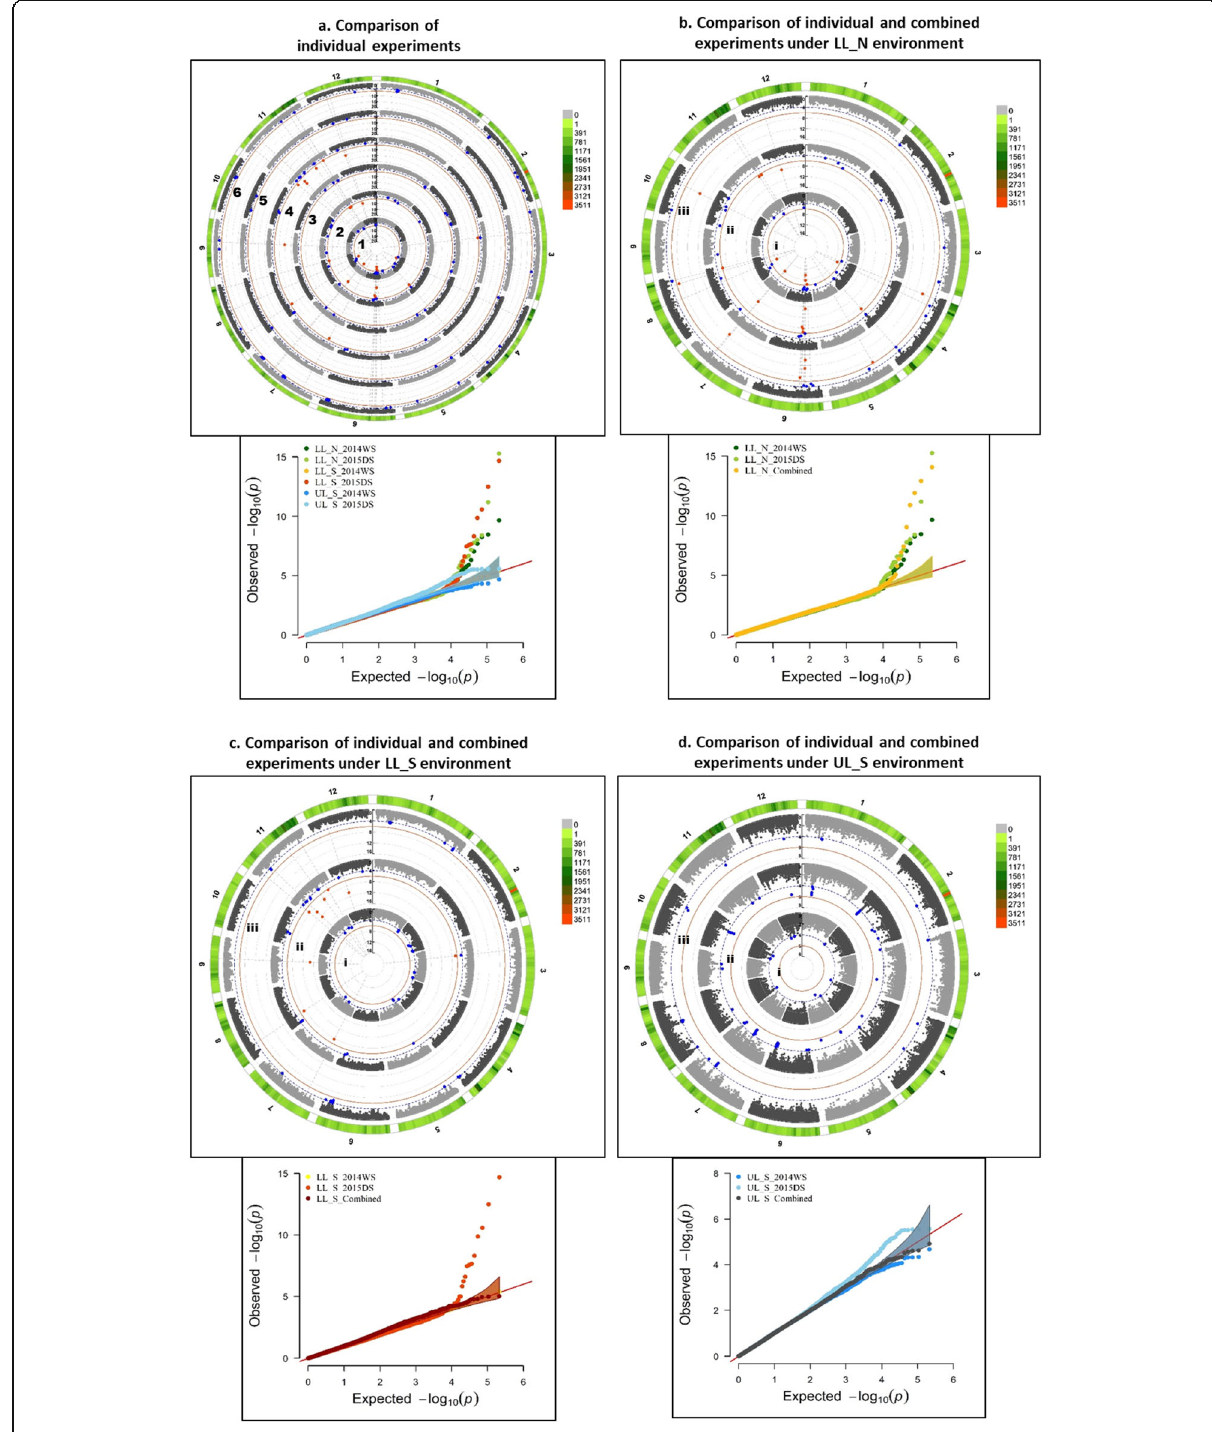
Fig. 4 Circular manhattan plot and qq plot for Days to 50% flowering (DTF). a. Each of the six experiments (from centre of the plot- 1. lowland non-stress 2014WS(LL_N_WS); 2. lowland non-stress 2015DS (LL_N_DS); 3. lowland stress 2014WS (LL S WS): 4. lowland stress 2015DS (LL_S_DS); 5. upland stress 2014WS (UL_S_WS) and 6. upland stress 2015DS (UL_S_DS) for p -values obtained using Farm-CPU method at two significance thresholds of 1e-4 (blue) and 1e-6 (red). The outermost ring depicts the SNP distribution in the 215,250 SNP working set. Individual experimental results are compared to the combined analysis for each of the three environments- b. LL_N, c . LL_S and d . UL_S, to detect seasonal variation between WS and DS, from centre of the plot- i. WS, ii. DS and iii. Combined